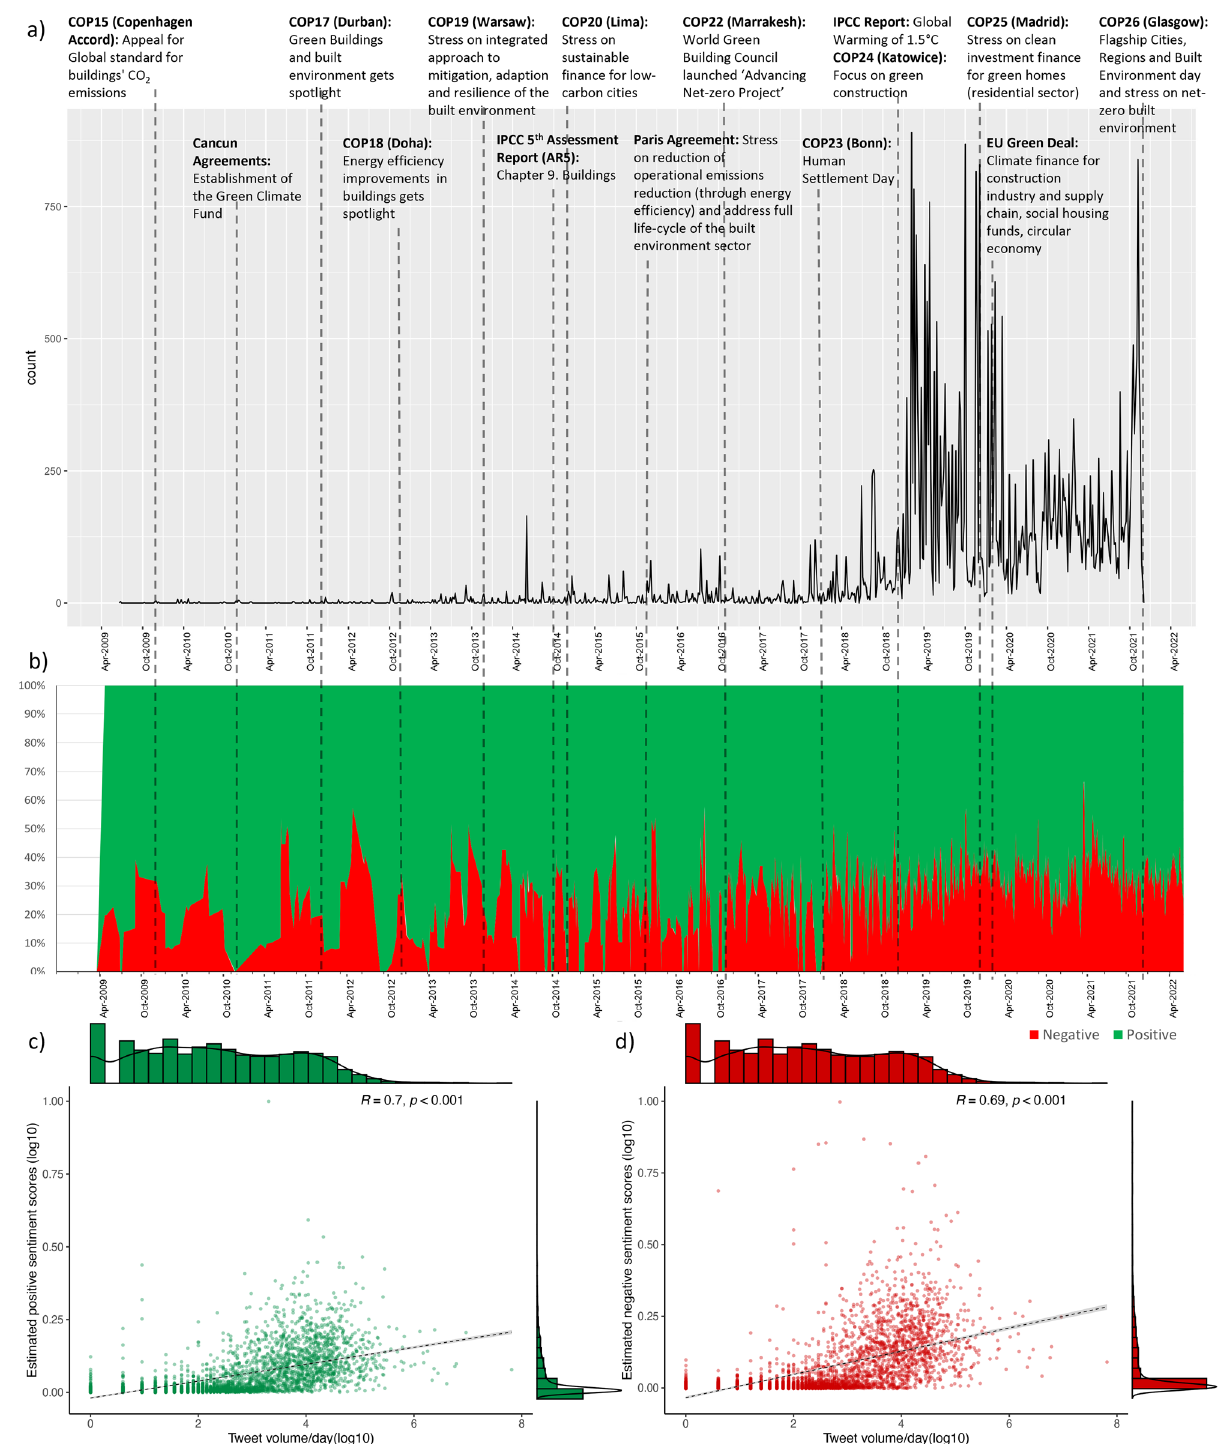
Figure 1. Time series of Twitter reactions concerning major climate negotiations and policy events (2009– 2021). ( a ) Twitter interactions (tweets, retweets, comments) with #emission and #building; ( b ) 6-month moving average estimates of tweet sentiments; ( c ) Spearman correlation between negative sentiments with daily tweet volume. The adjusted R-squared value is 0.296, standard error is 0.192 significant at 0.001 level, ( d ) Spearman correlation between positive sentiments with daily tweet volume. The adjusted R-squared value is 0.299, and the standard error is 0.271, significant at the 0.001